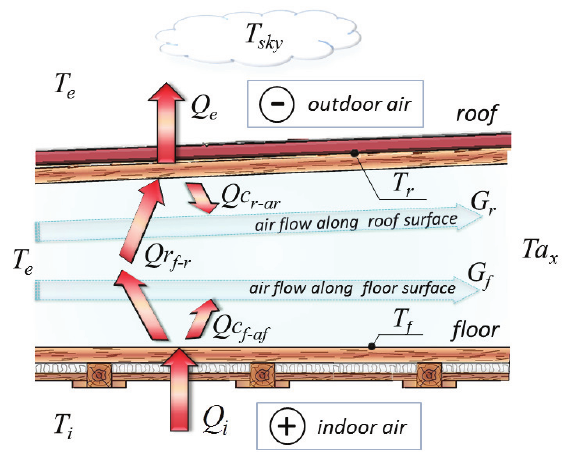
Fig. 2. Scheme of the heat flows in the attic under winter conditions Note: Q i – heat flow from the room to the attic space; Qc f-af – con- vective heat flow from the floor surface to the air near it; Qr f-r – radiative heat flow between the floor and internal roof surface; Qc r-ar – convective heat flow from the internal roof surface to the air near it; Q e – heat flow from the internal roof surface to the outdoor ambient is the sum of the three heat flows Q e = Qc r-e + Qr r-a + Qr r-sky ; Qc r-e – convective heat flow from the external roof surface to the outdoor air; Qr r-a – radiative heat flow be - tween the external roof surface and surrounding objects; Qr r-sky – radiative heat flow between the external roof surface and the